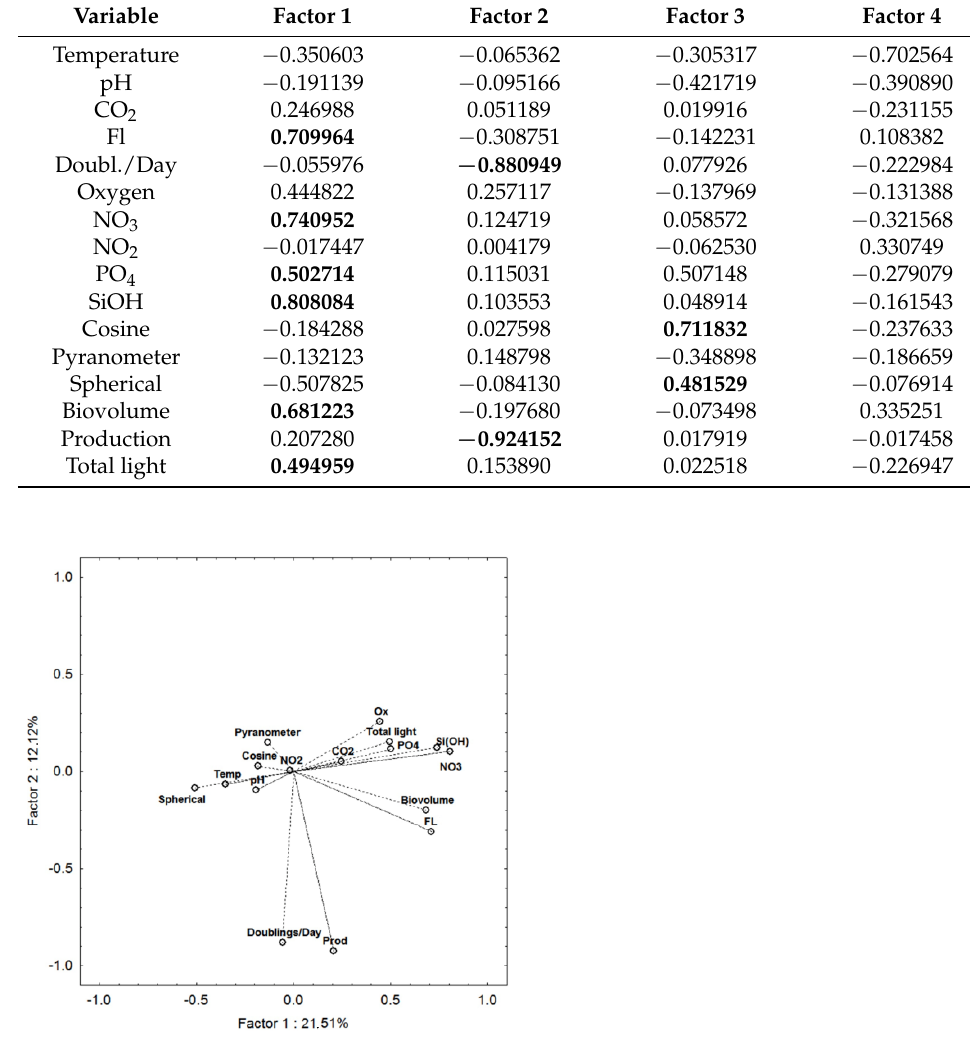
Figure 14. Orientation of data from the 300,000 L reactor at Finnfjord AS by axes formed by the two first factors in a PCA ordination analysis (n = 91). Table 5. PCA factor loadings from variable correlation matrix for four first factors in analysis of data (matrix since 16 cases × 206 active cases). Bold shows significant (5 %) loadings.